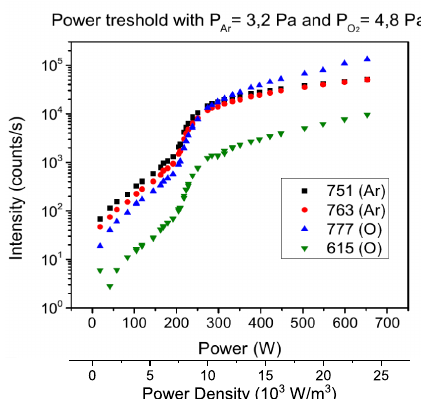
Figure 6. E–H mode transition at 8 Pa, with plasma composition of 40% Ar and 60% O 2 .